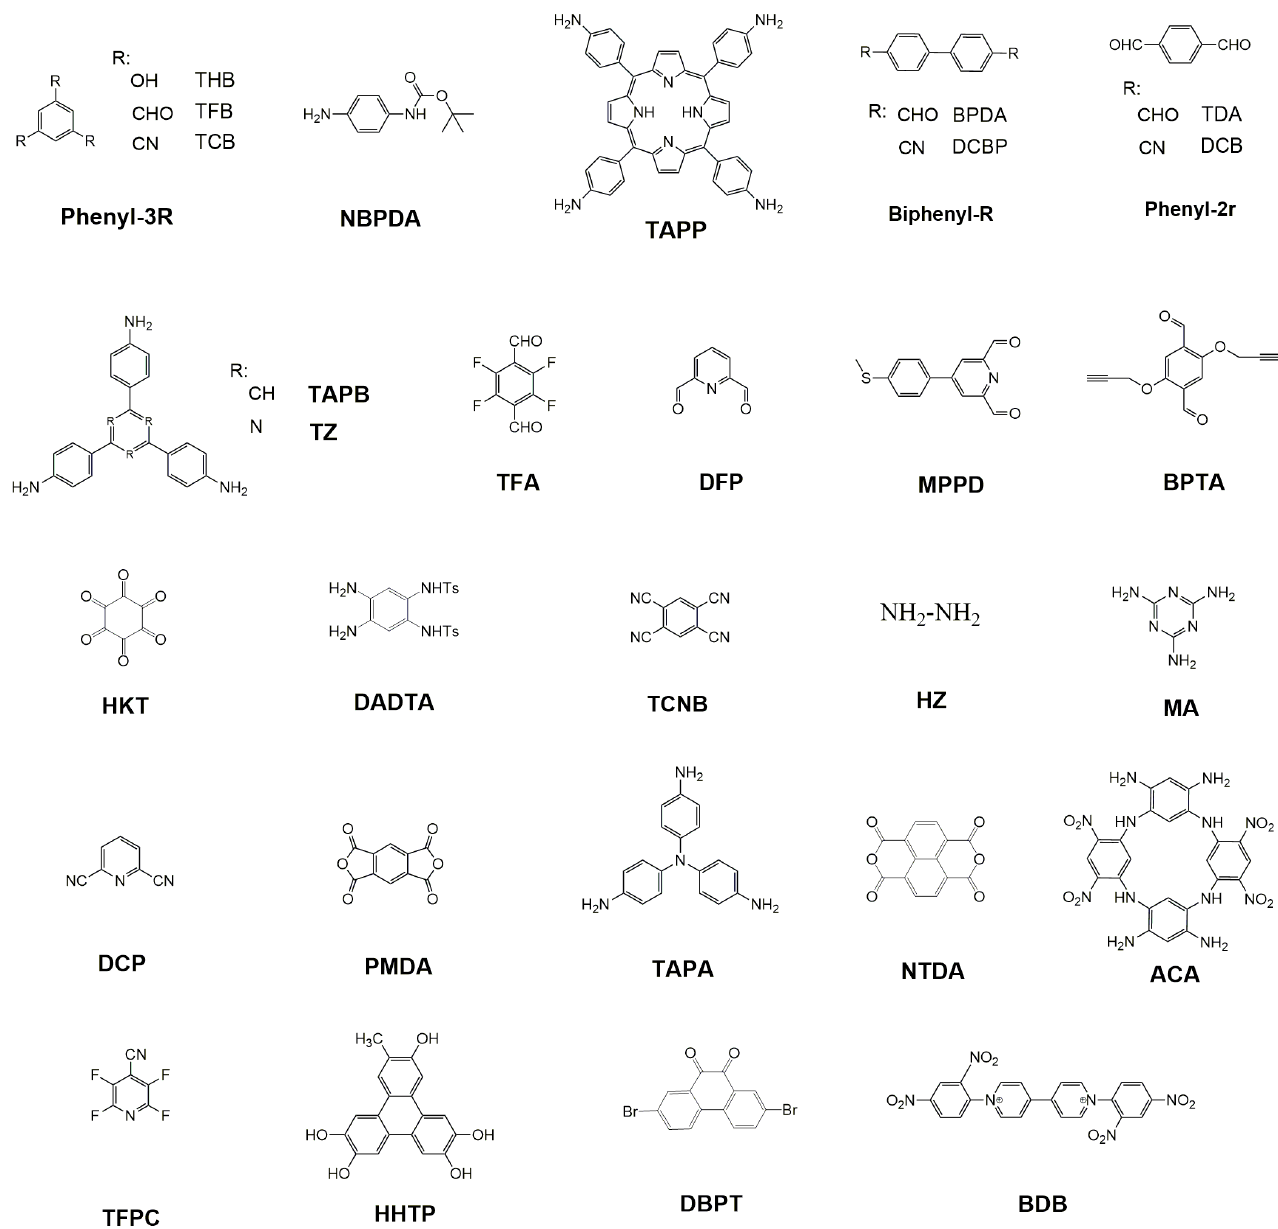
Figure 1. Monomers used in the recent papers discussed in this review.